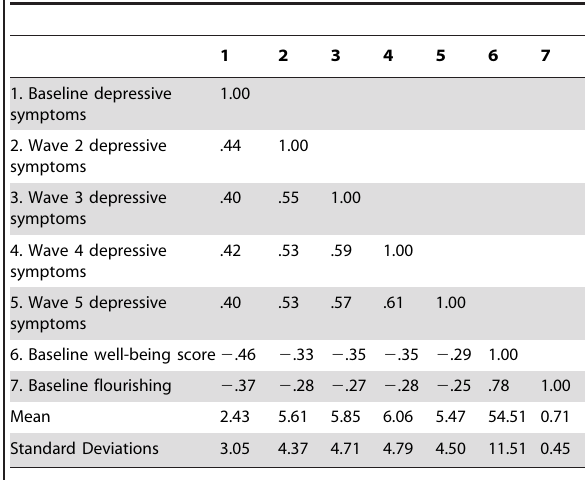
Table 2. Means, Standard Deviations, and Zero-Order Correlations of Main Predictor Variables and Outcome Variables.